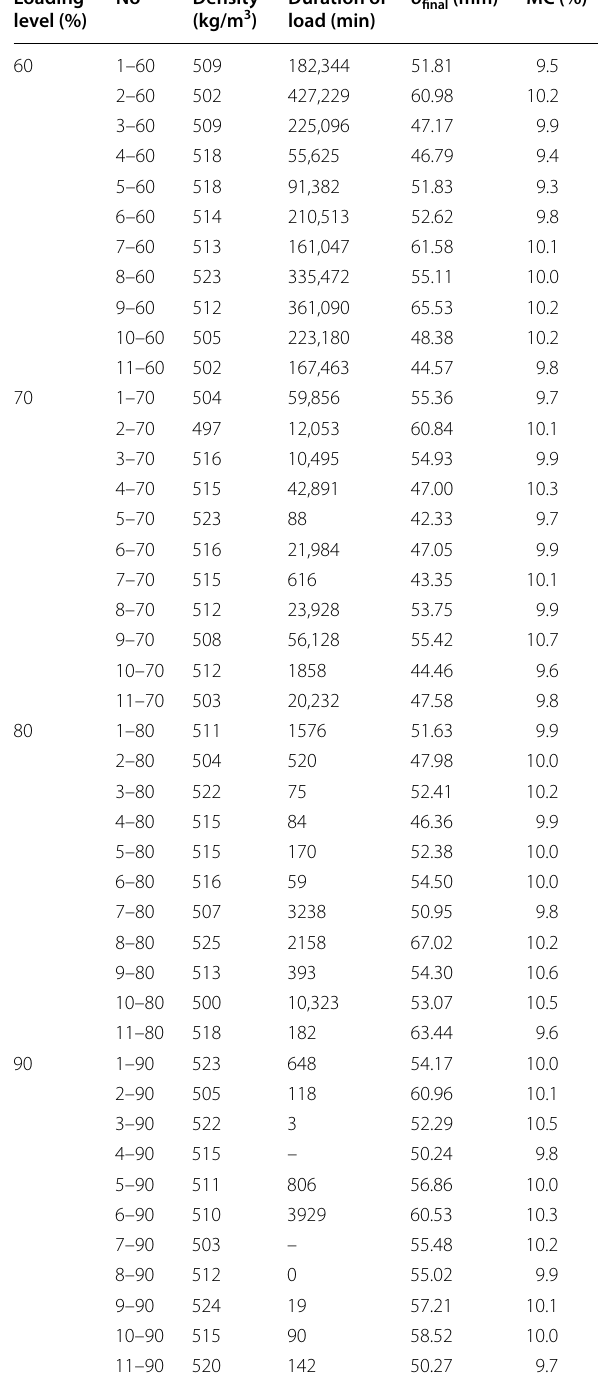
δ final is the final recorded deflection before failure and MC is moisture content. Specimens with brank data had failure before the completion of loading